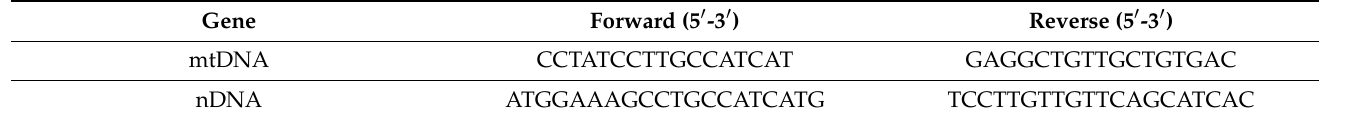
Table 2. List of primer sequences used in qRT-PCR for mtDNA